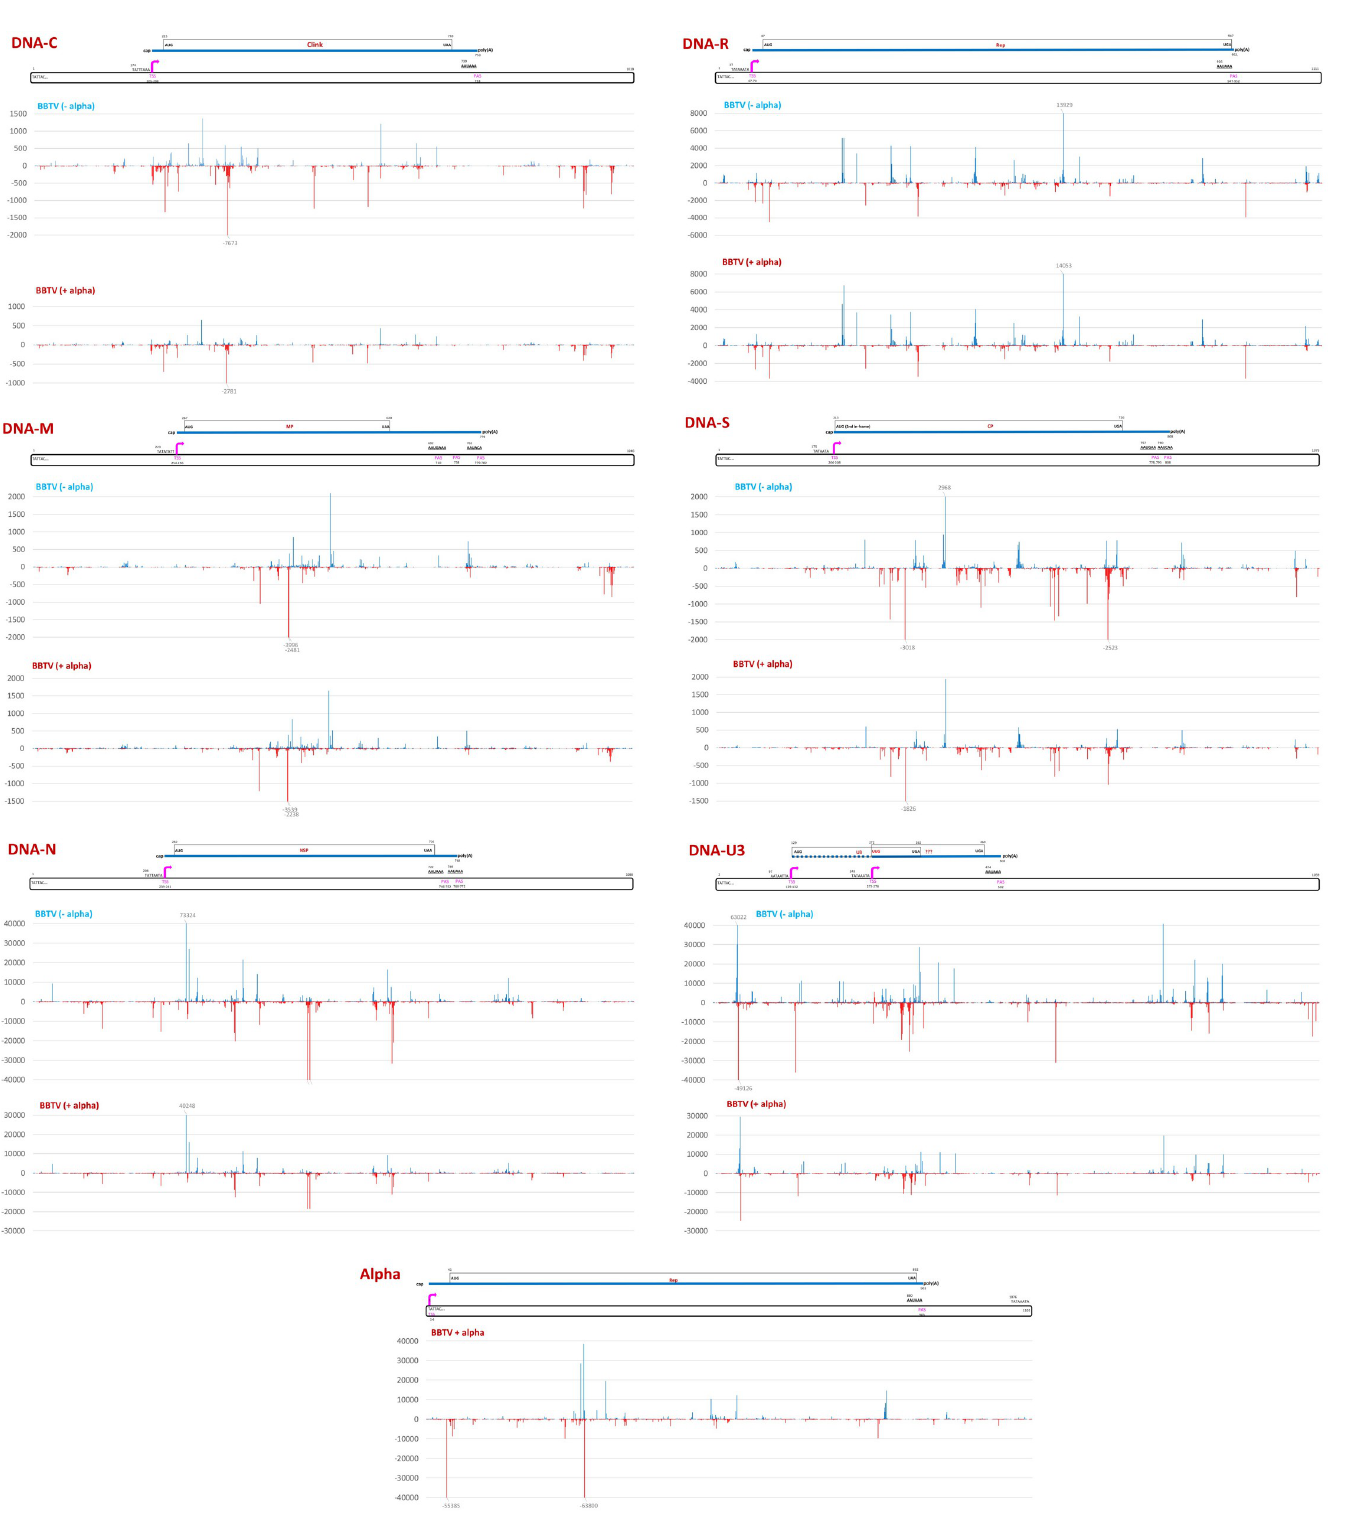
Fig 9. Single nucleotide resolution maps of Illumina sRNA-seq reads representing viral siRNAs from BBTV-infected Cavendish banana plants with or without DRC alphasatellite. For each of the two conditions, i.e. without (BBTV-alpha) and with (BBTV+alpha) alphasatellite, Illumina 20–25 nt reads of the three biological